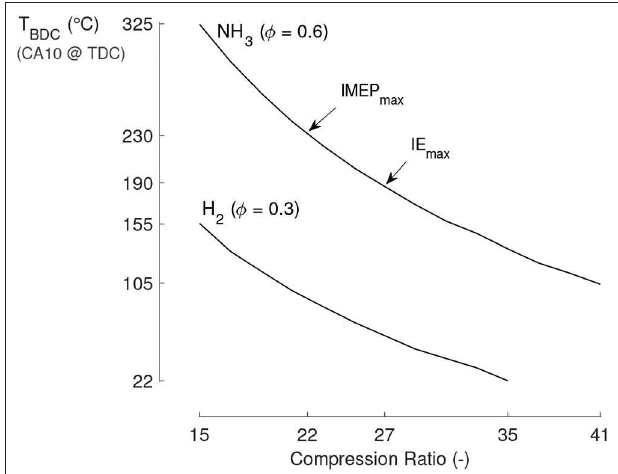
FIGURE 2 | Coupling of a single-zone model (Pochet et al., 2017a) with a wiebe function (8 CAD combustion duration) to obtain sensible pressure curves, IMEP and IE performances. For an atmospheric intake pressure and the engine constraints of P max = 120 bar and MPRR = 12 bar / CAD, the highest achievable IMEP is obtained at 22:1. Increasing the compression ratio allows to increase the IE and decrease the required intake temperature but decreases the achievable equivalence ratio, hence the maximal